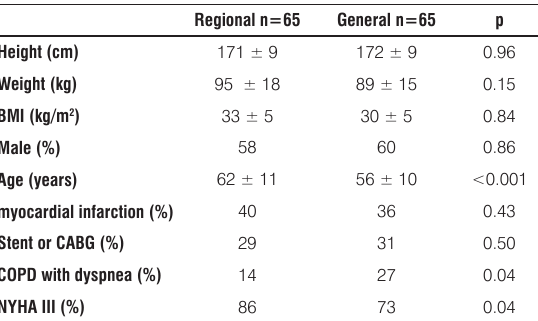
Table 1. Biometric data and pre-existing conditions.